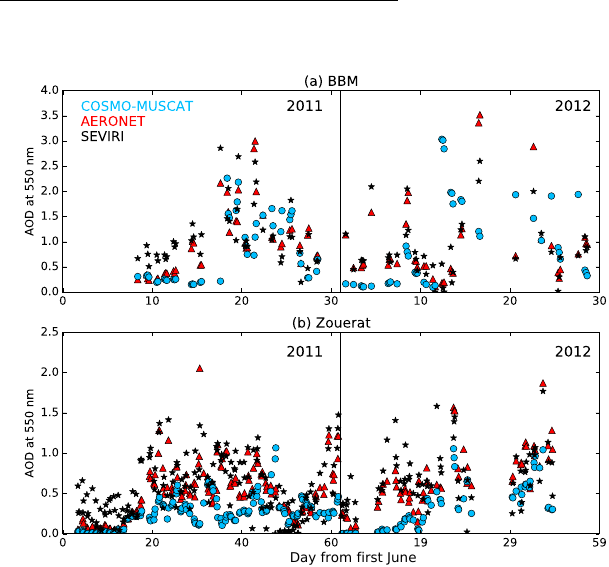
Figure 8. Time-series of measurements, retrievals, and simulations of AOD at 550nm over the Fennec BBM and Zouerat AERONET sites, during 2011 and 2012 when AERONET data are avail- able, linked into one time-series: (a) BBM, the 2 June months; (b) Zouerat, the 4 months of June and